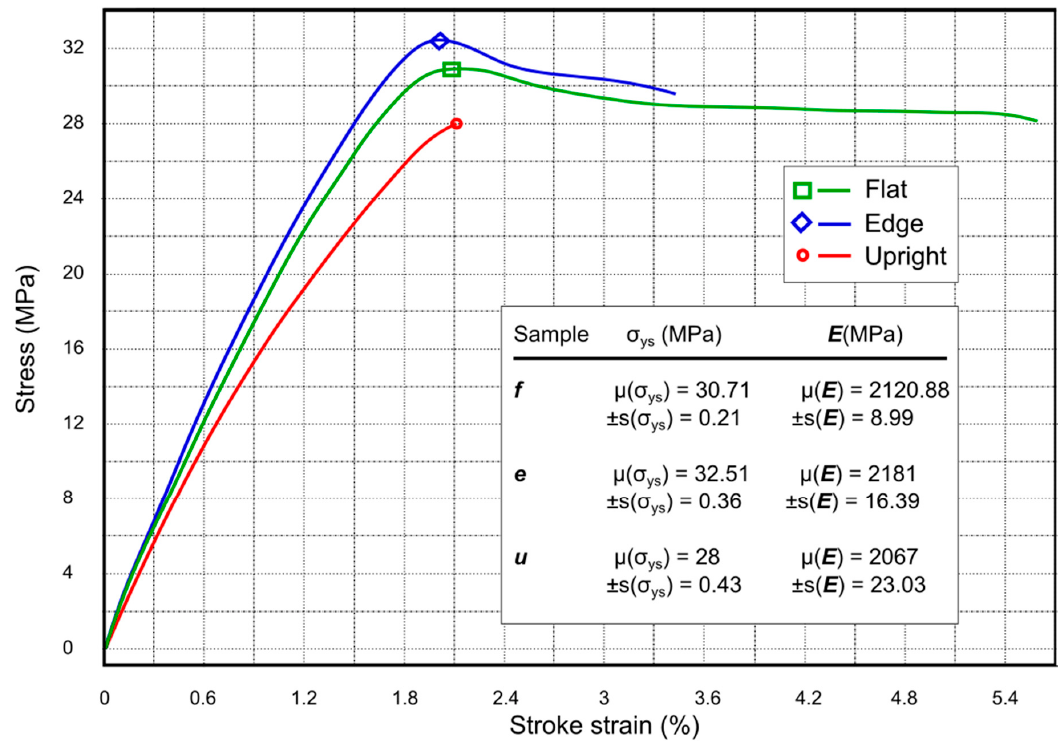
Figure 4. Evaluated strain–stress curve of the samples of f , e , and u . Experimental results of mean ( µ ) and standard deviation ( s ) of yield strength σ ys and Young’s modulus E .